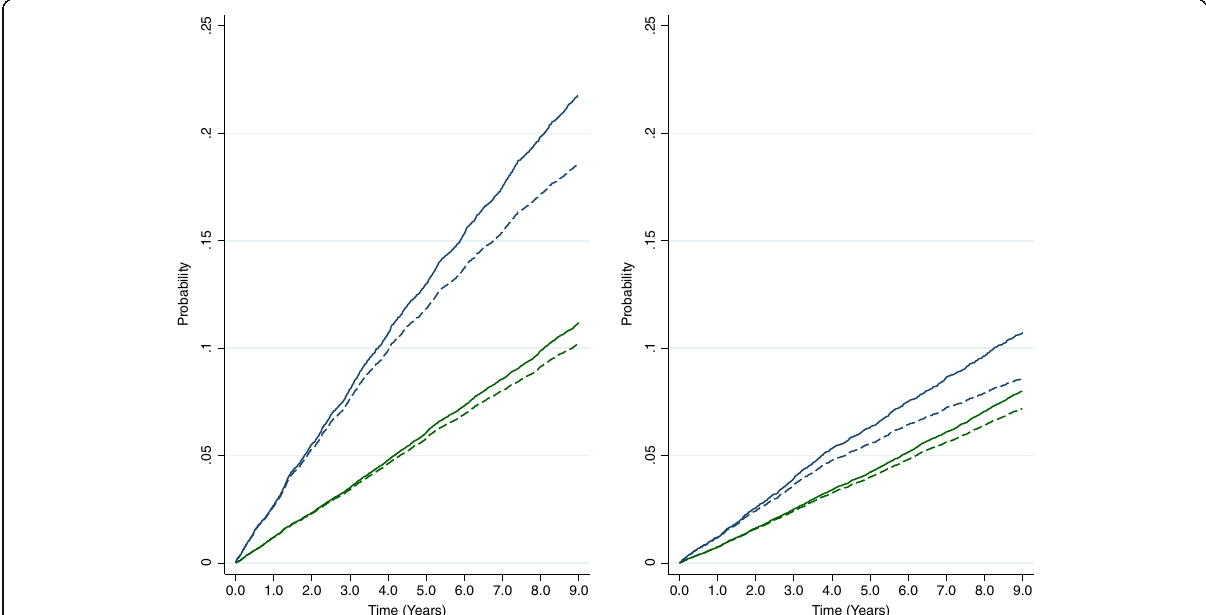
Fig. 1 Cumulative risk estimates for cardiovascular (left) and cancer (right) mortality. Kaplan-Meier, solid lines; cumulative incidence competing risk, dashed lines; normoalbuminuria, green lines; albuminuria, blue